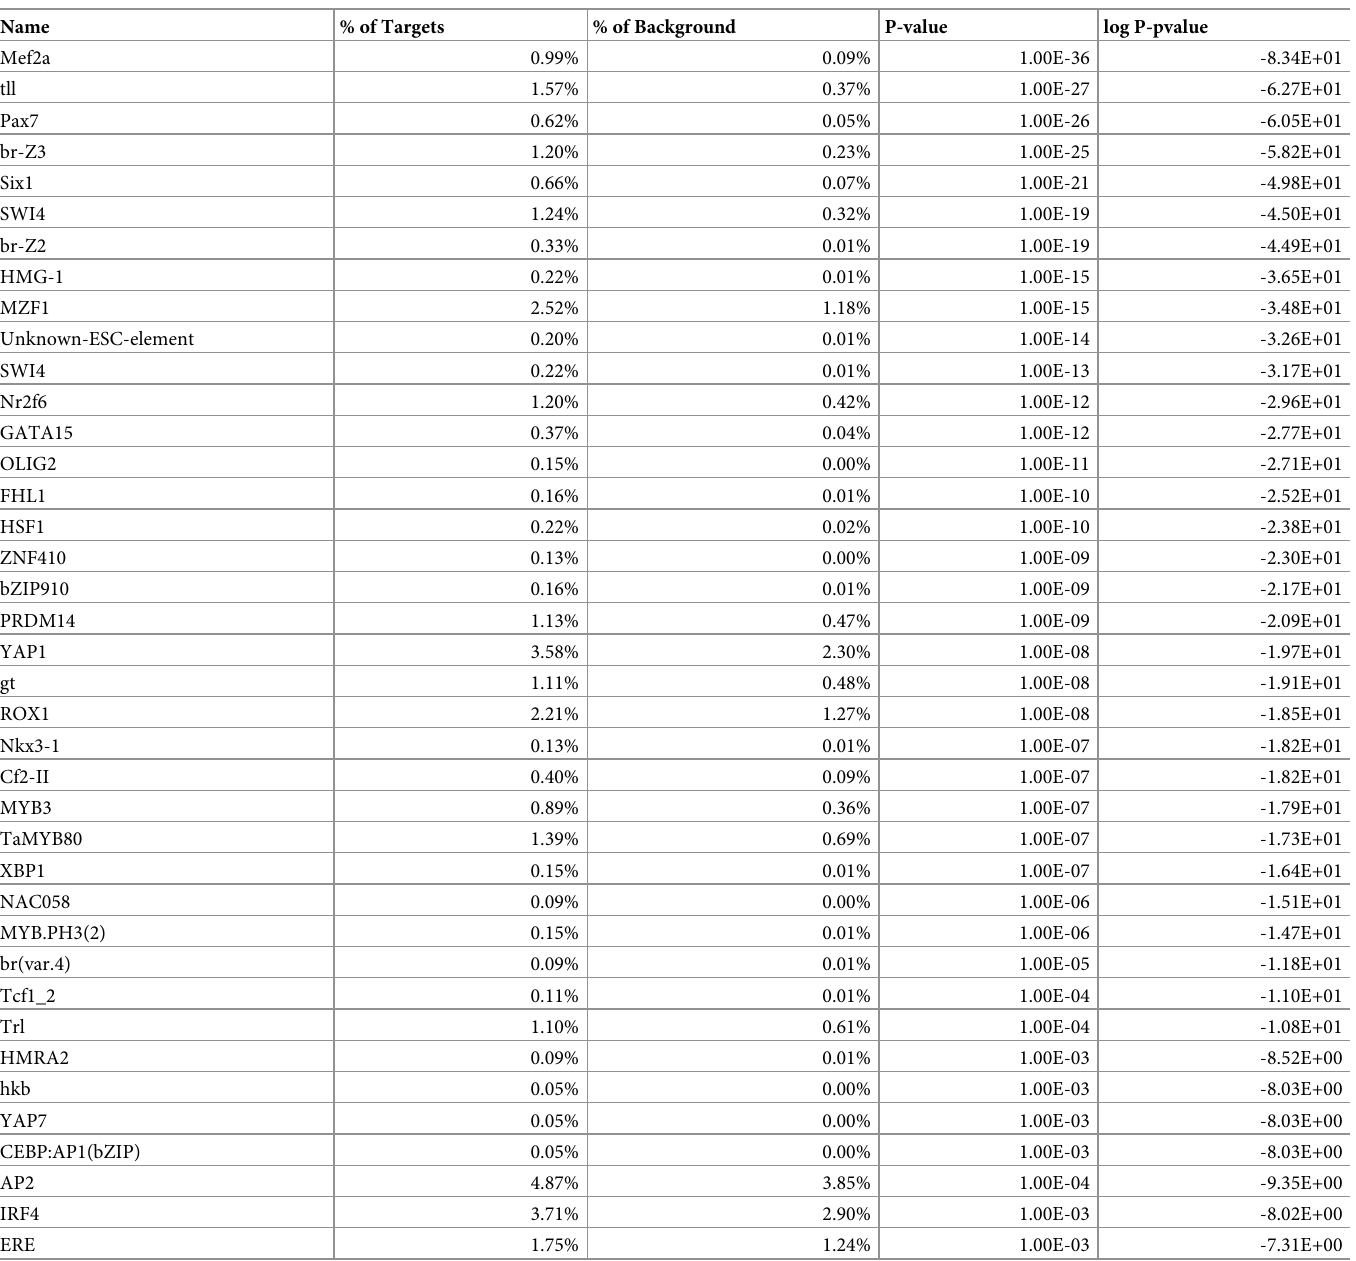
Table 4. LD enriched